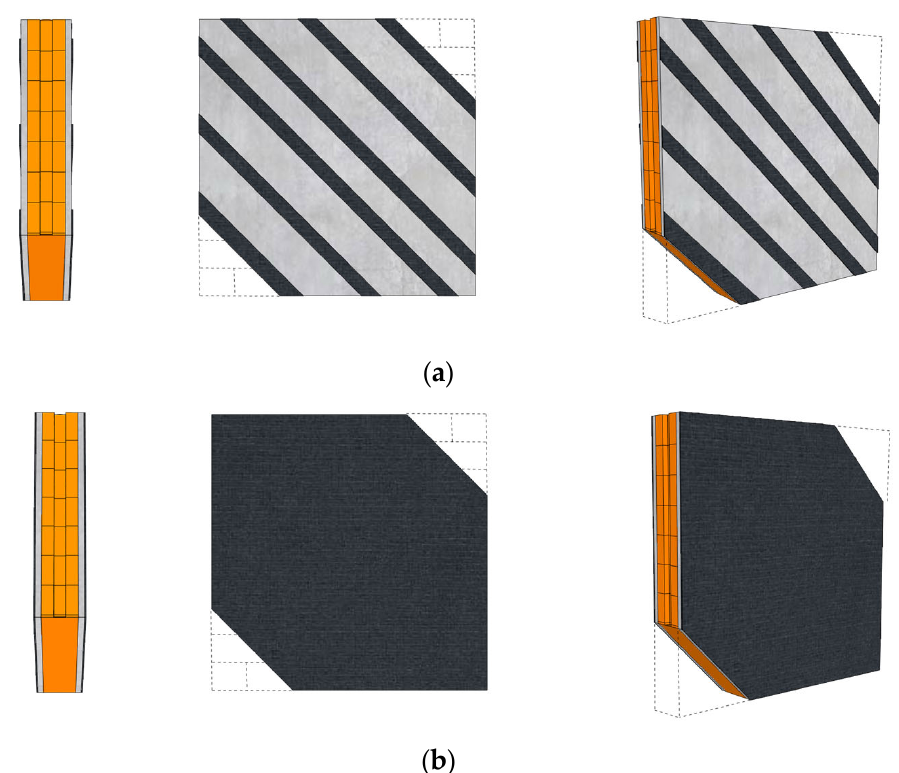
Figure 1. Typical strengthening details: ( a ) Configuration A; ( b ) Configuration B.